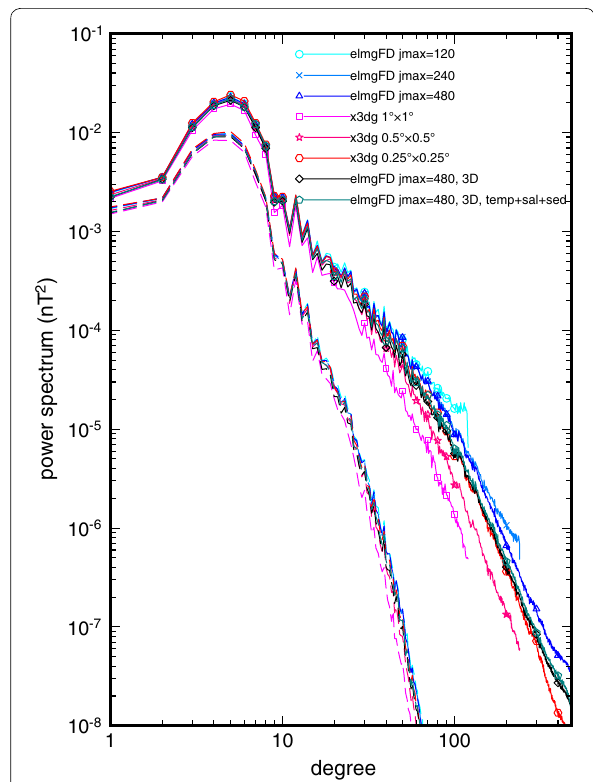
Fig. 3 Geomagnetic power spectra. Geomagnetic power spectra at the Earth surface (solid lines and symbols) and at the satellite altitude of 400 km (dashed lines). Results of the 2-D approaches elmgFD and x3dg are shown for increasing resolution and compared with two calculations of elmgFD in 3-D